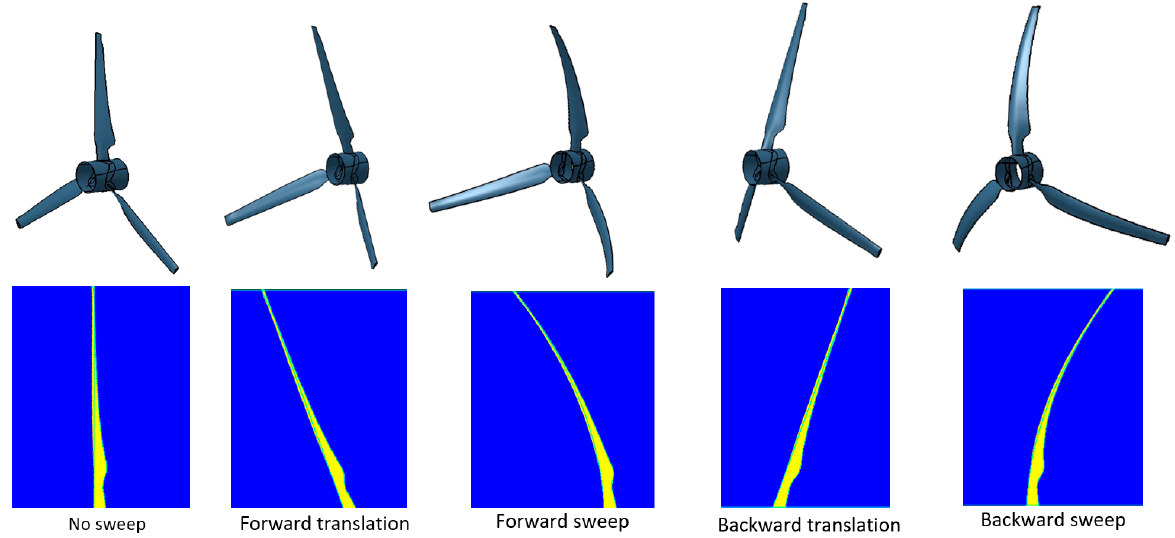
Figure 36. Different definitions of sweep applied to a wind turbine rotor.